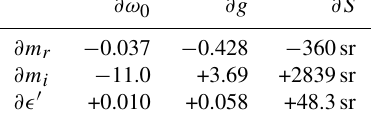
Table 6. Elements of the Jacobian matrix, i.e., first partial deriva- tives, of a dust-like ensemble (see text for details). ∂ω 0